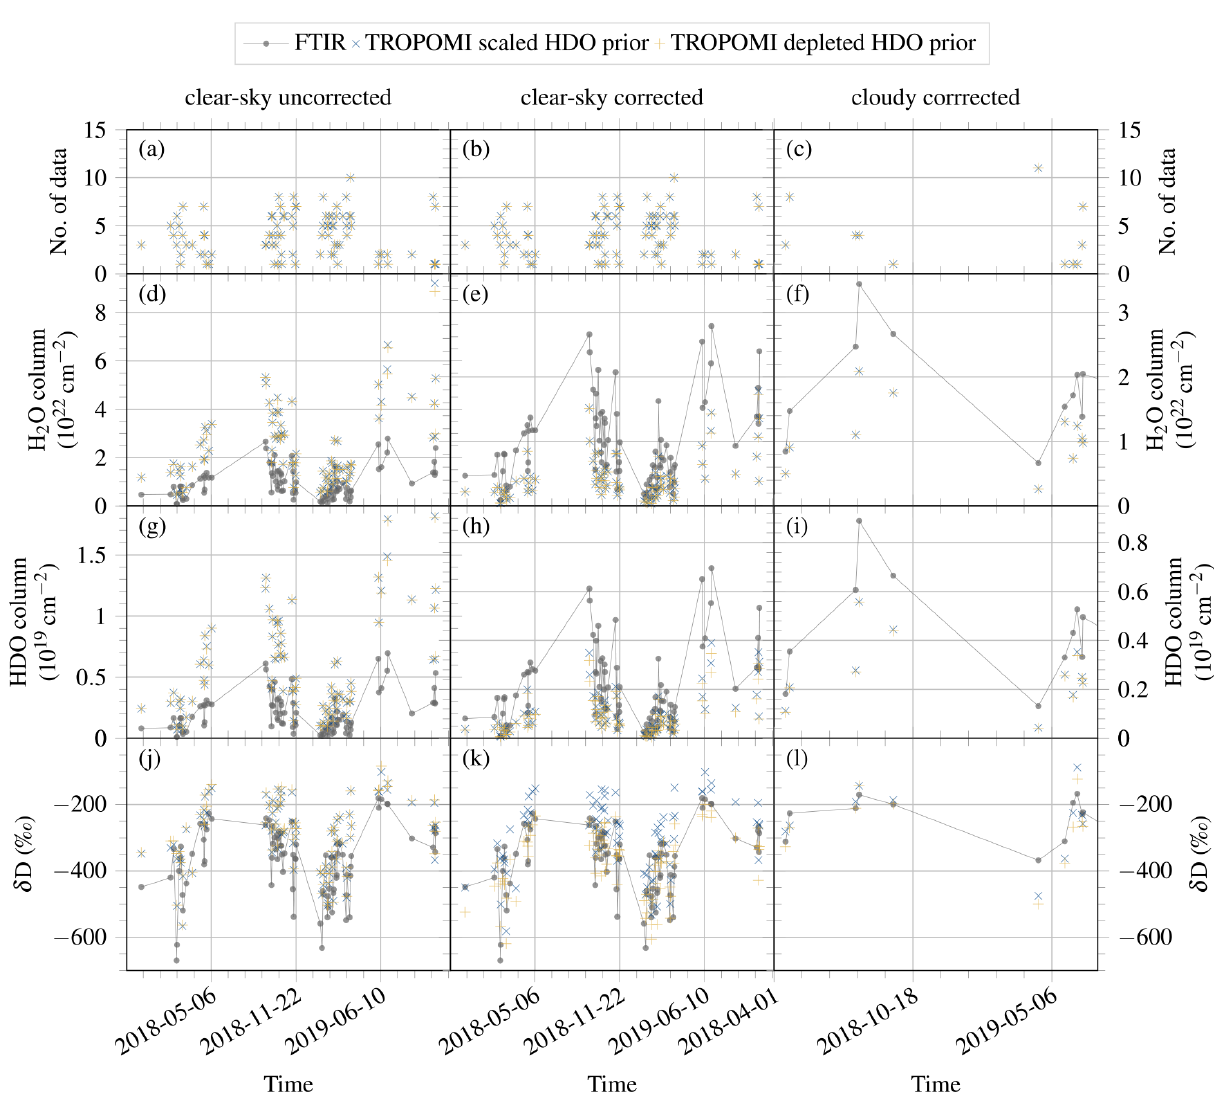
Figure 11. Time series of (a–c) the number of individual measurements per day, (d–f) bias in the H 2 O column, (g–i) bias in the HDO column, and (j–l) bias in δ D at the high-altitude station Zugspitze (2964ma.m.s.l.). The left panels (a) , (d) , (g) and (j) show clear-sky measurements without altitude correction, the centre panels (b) , (e) , (h) and (k) show the same measurements with altitude correction, and the right panels (c) , (f) , (i) and (l) show observations over optically thick clouds within an altitude range 1000m above and 500m below the station height. Please note that in the left panels the H 2 O and HDO axes are different than in the centre and right panels, as indicated by the axis ticks. The blue points correspond to the standard prior which is scaled from the humidity profile, while the yellow points correspond to the prior computed assuming a more realistic δ D